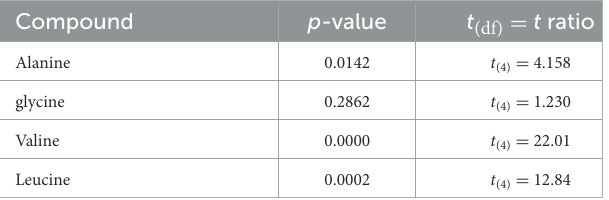
TABLE 4 Renuspore ® increased FAA in UHT fermented milk compared with the control (uninoculated UHT milk): ∗ p ≤ 0.05.